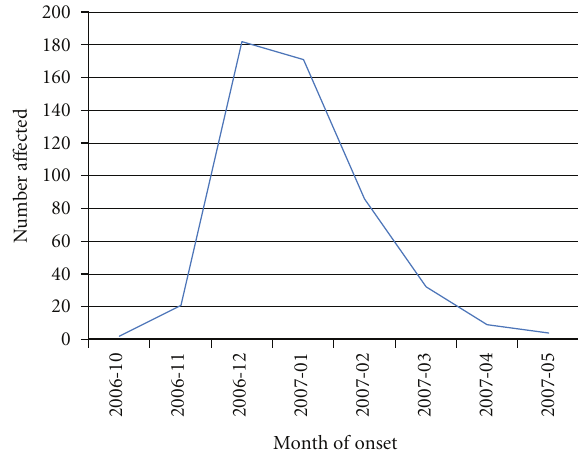
Figure 1: Temporal relationship of chikungunya incidence in